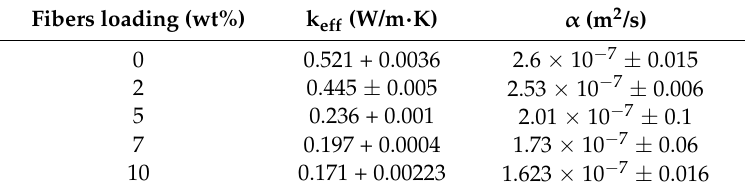
Table 4. Thermal conductivity and thermal diffusivity of composite samples for different mass